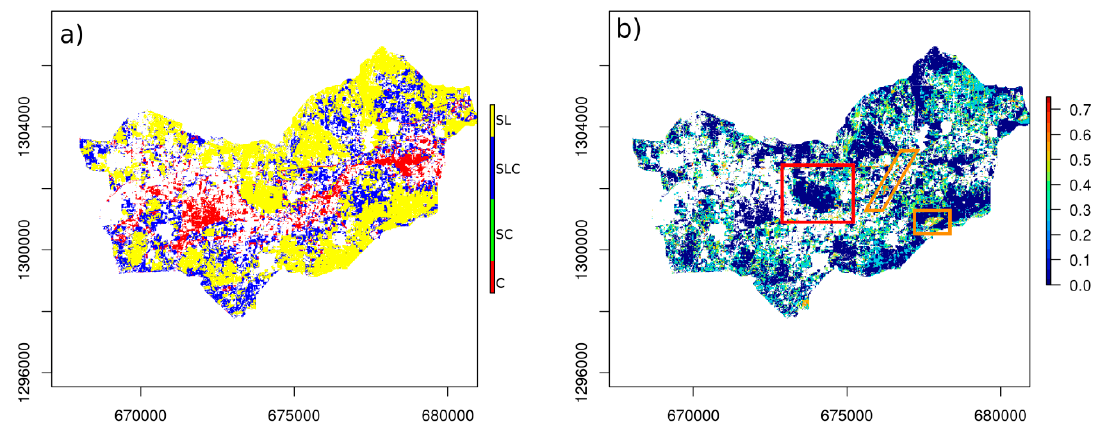
Figure 9. Map of ( a ) the most frequent textural class and ( b ) the Simpson’s diversity index, both calculated from the time series of six classifications. The white areas correspond to the masked mixed pixels.